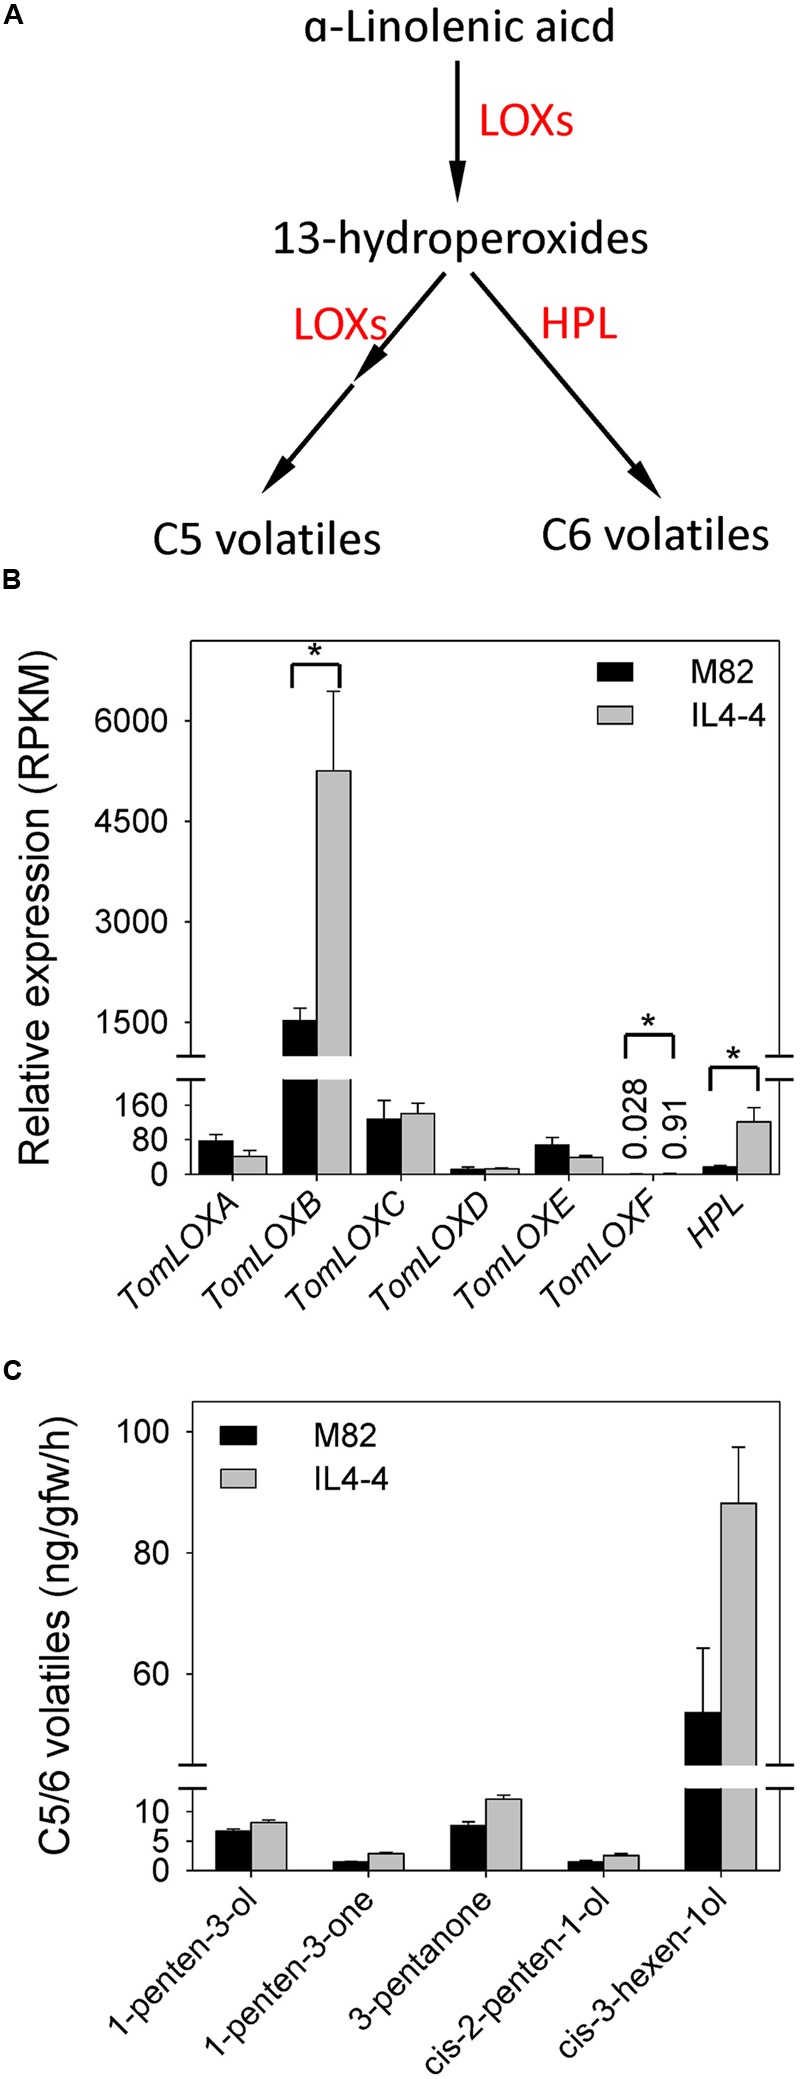
Levels of volatiles and transcripts in the fatty acid pathway in IL4-4 and M82. (A) Schematic representation of the C5 and C6 volatile biosynthetic pathway based on Shen et al. (2014). HPL, hydroperoxide lyase; LOXs, lipoxygenases. (B) Expression of LOX f and HPL genes in ripe tissue of IL4-4 and M82. Ratio (±SE) was calculated by the average RPKM value. An asterisk indicates RPKM ration change >2 and adjusted p < 0.05. (C) levels of C5 and C6 volatiles (±SE) significantly different (p < 0.05, n > 5) between IL4-4 and M82.